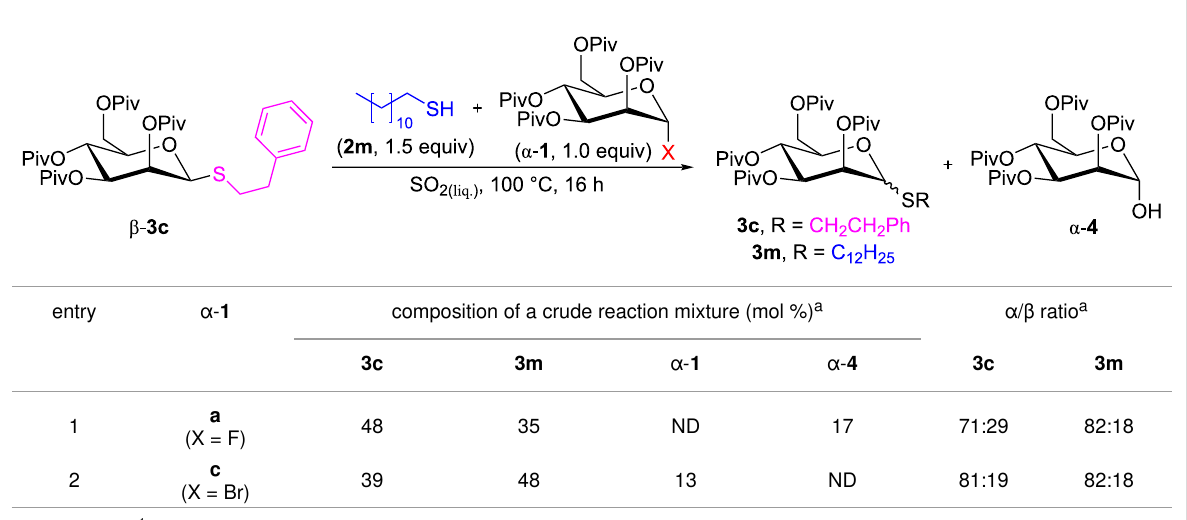
Table 6: Anomerization of thiomannoside β - 3c under glycosylation